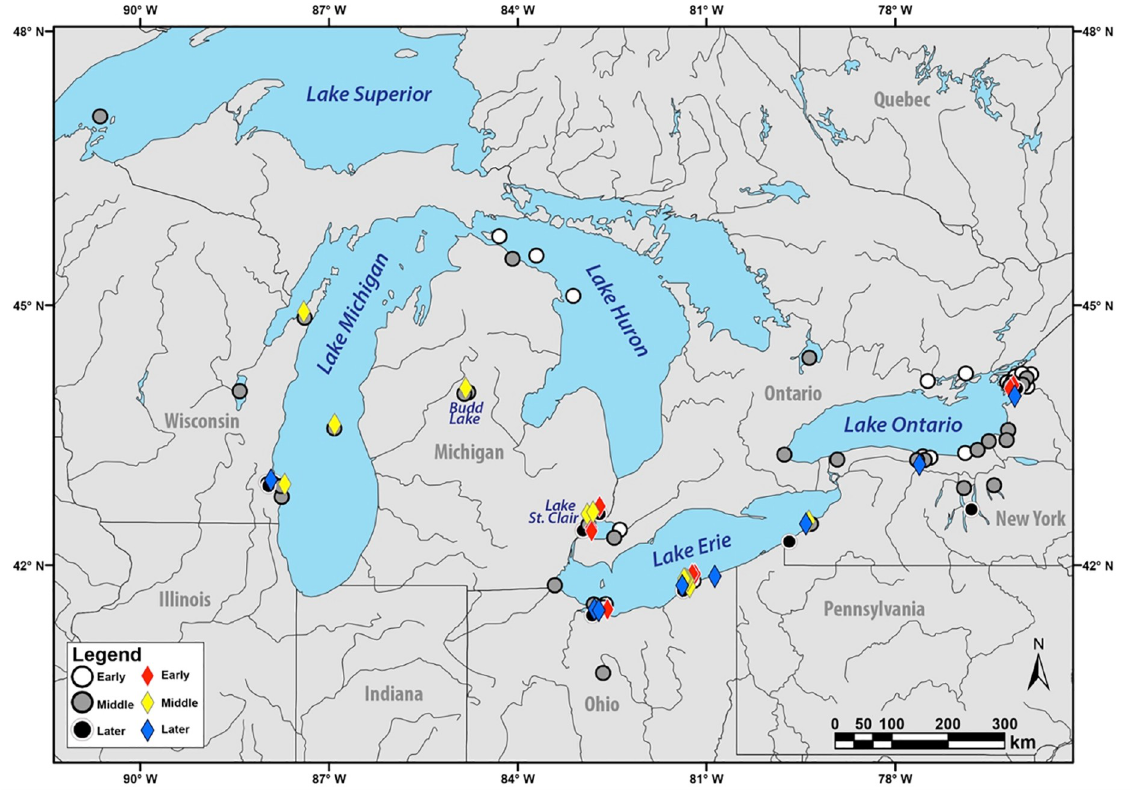
Fig 1. Map of VHSV-IVb occurrences in the Great Lakes region. Shapes are colored according to time periods of sample collections (Early: 2003–2006, Middle: 2007–2010, Later: 2011–2020). Diamonds denote isolates with sequenced whole genomes. Large circles depict VHSV-IVb isolates lacking whole genome data, at the time of this study. Map was created by MDN using ArcGIS software (https://www.esri.com) under the Department of Environmental Sciences of the University of Toledo’s license, and using freeware from Natural Earth (https://www. naturaalearthdata.com), a public domain